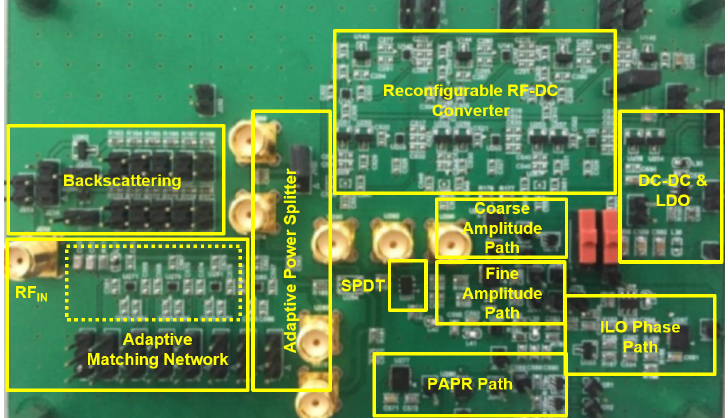
Figure 9. Measurement board of 900 MHz dual-mode SWIPT system.